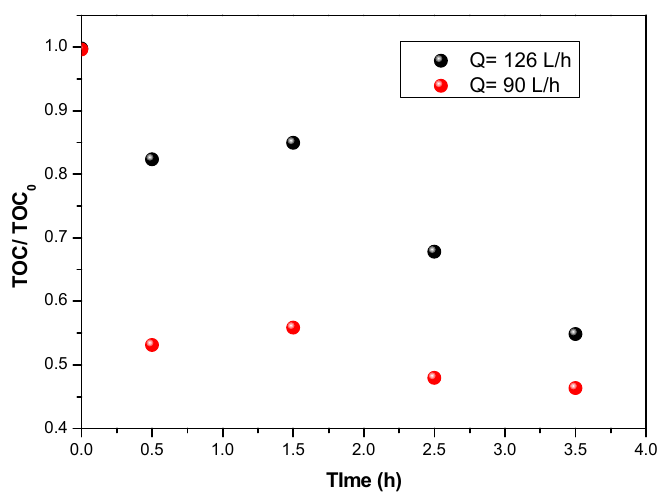
Figure 8. Evaluation of TOC during the degradation of flumequine for two flow rates (90 L/h and 126 L/h) at an initial concentration of 5 mg/L and UV of 38 W/m 2 .